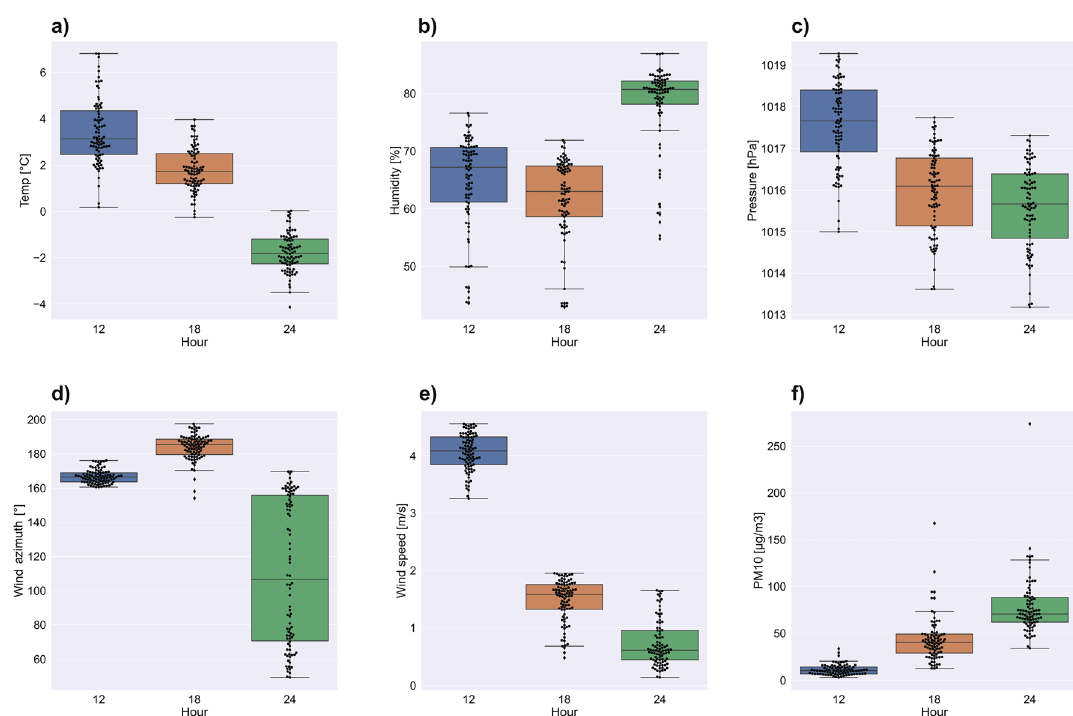
Figure 5. Box and swarm plots for temperature ( a ), humidity ( b ), pressure ( c ), wind azimuth ( d ), wind speed ( e ), and PM10 concentration ( f ) on the 18th of